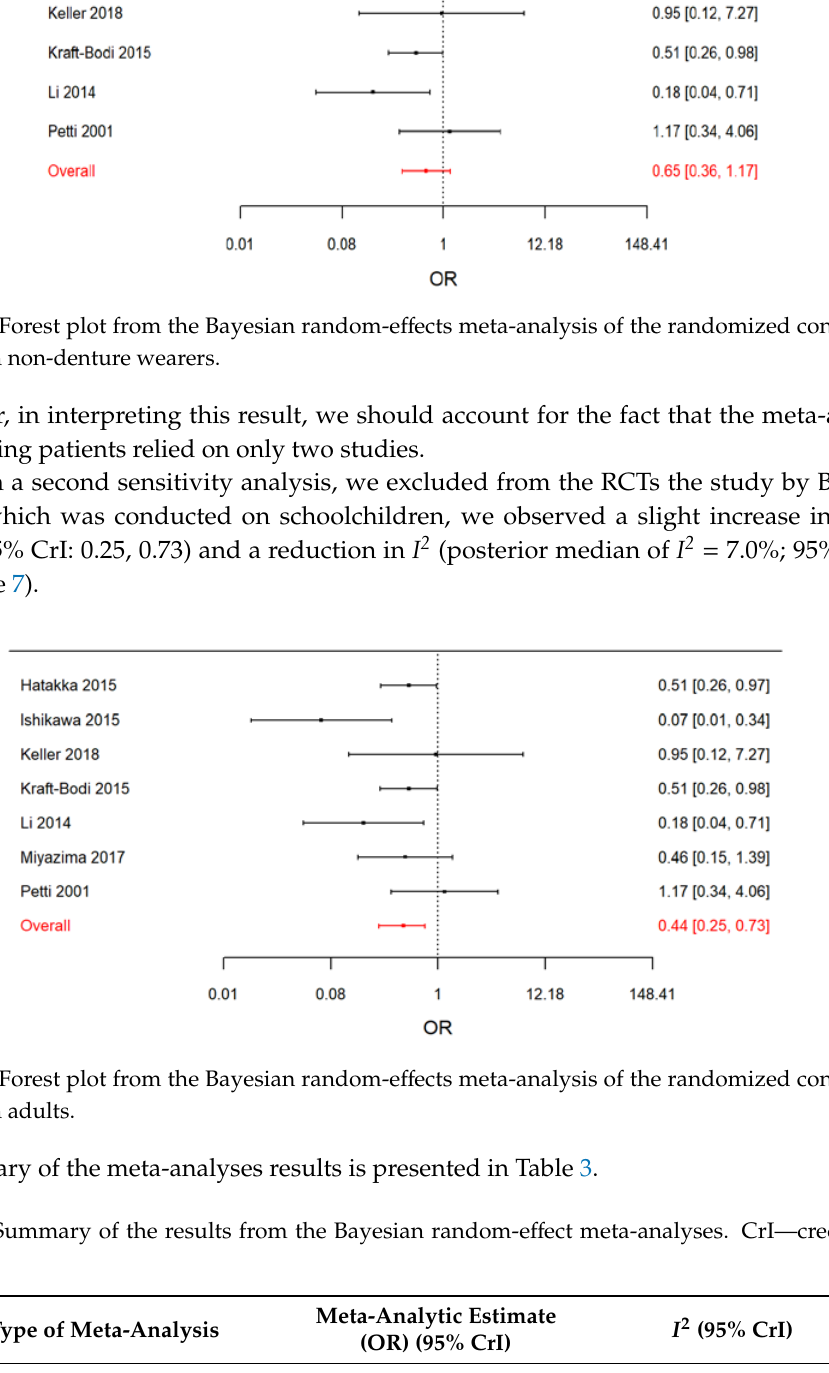
Figure 6. Forest plot from the Bayesian random-effects meta-analysis of the randomized controlled studies on non-denture wearers.